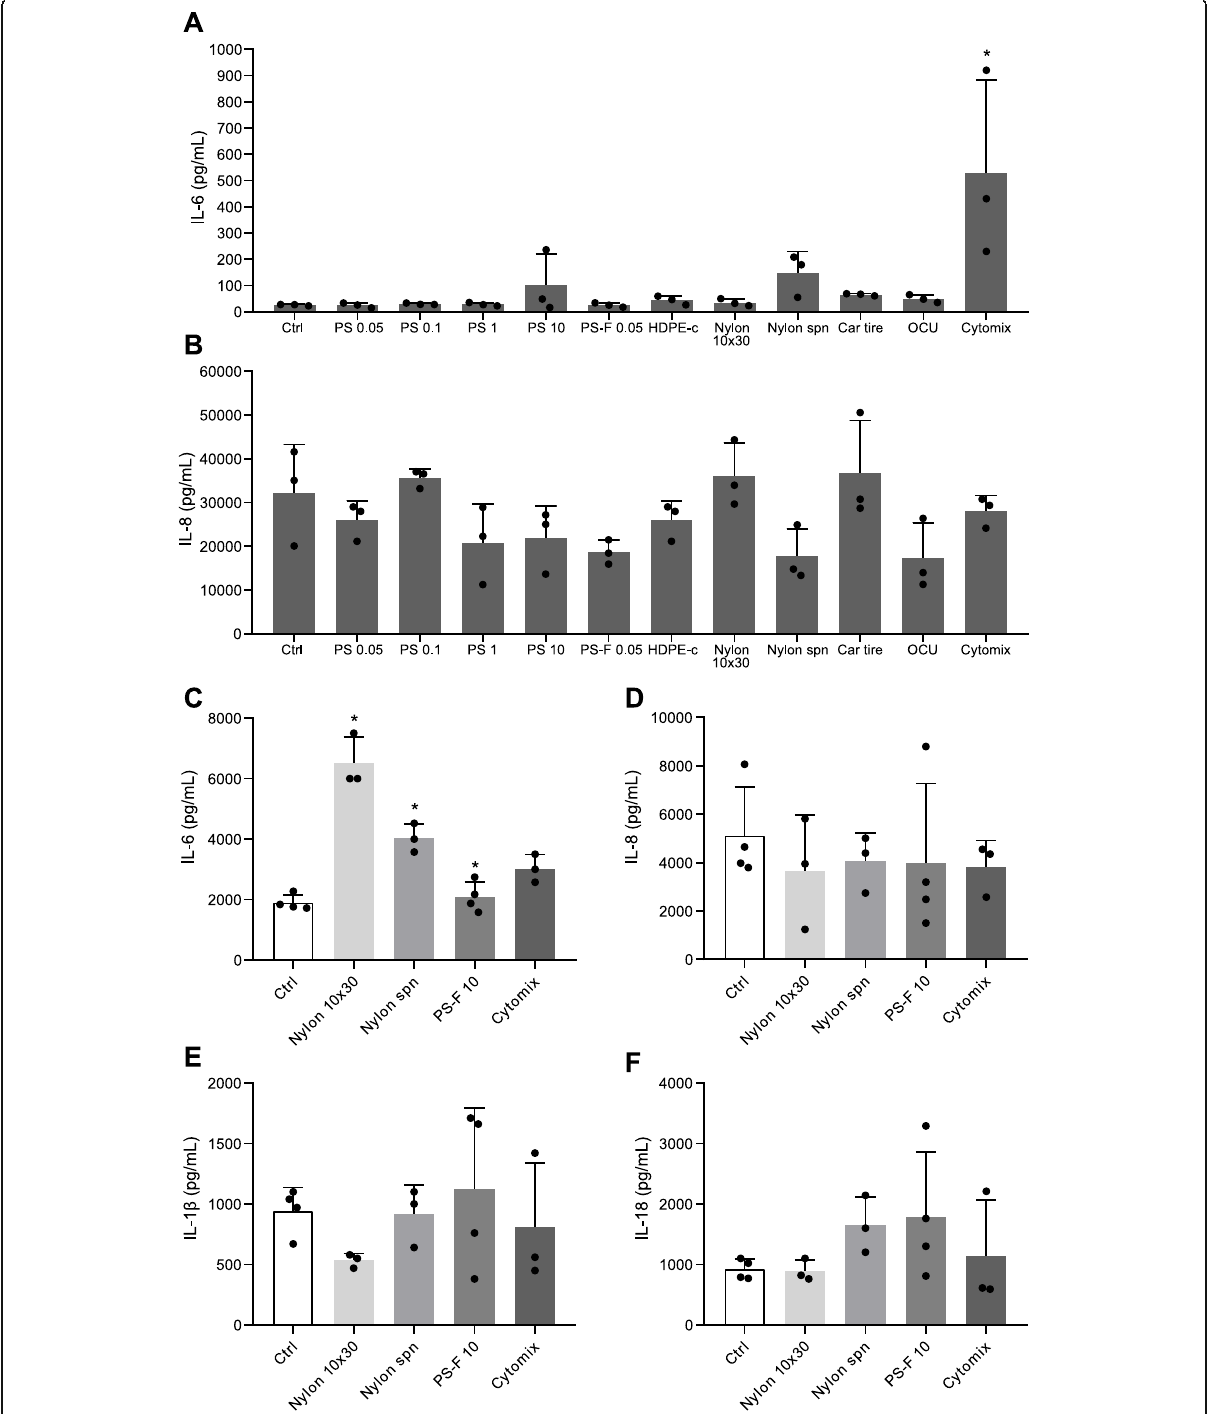
Fig. 4 Pro-inflammatory cytokine release by lung epithelial cells or porcine colon intestinal tissue explants upon 96 or 24 h exposure, respectively, to MNP (1 mg/mL). A-B IL-6 ( A ) and IL-8 ( B ) secretion into the basolateral compartment by lung epithelial cells (MucilAir ™ ) after 96 h (n = 3). C-F IL-6 ( C ), IL-8 ( D ), IL-1 β ( E ) and IL-18 ( F ) secretion into the basolateral compartment by porcine colon tissue explants mounted in the IEBC after 24 h (n = 3 – 4). Data are presented as mean ± SD . * p < 0.05 compared to the control condition, calculated by one-way ANOVA (Dunnett ’ s multiple